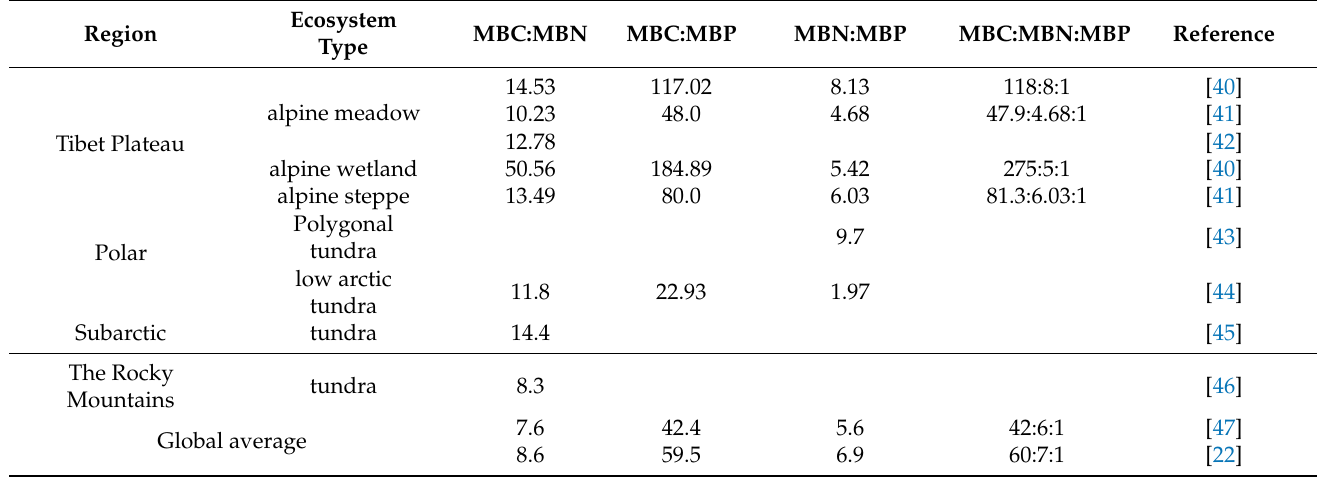
Table 1. Summary of C:N:P stoichiometric ratios for soil microbial biomass in alpine ecosystems and global